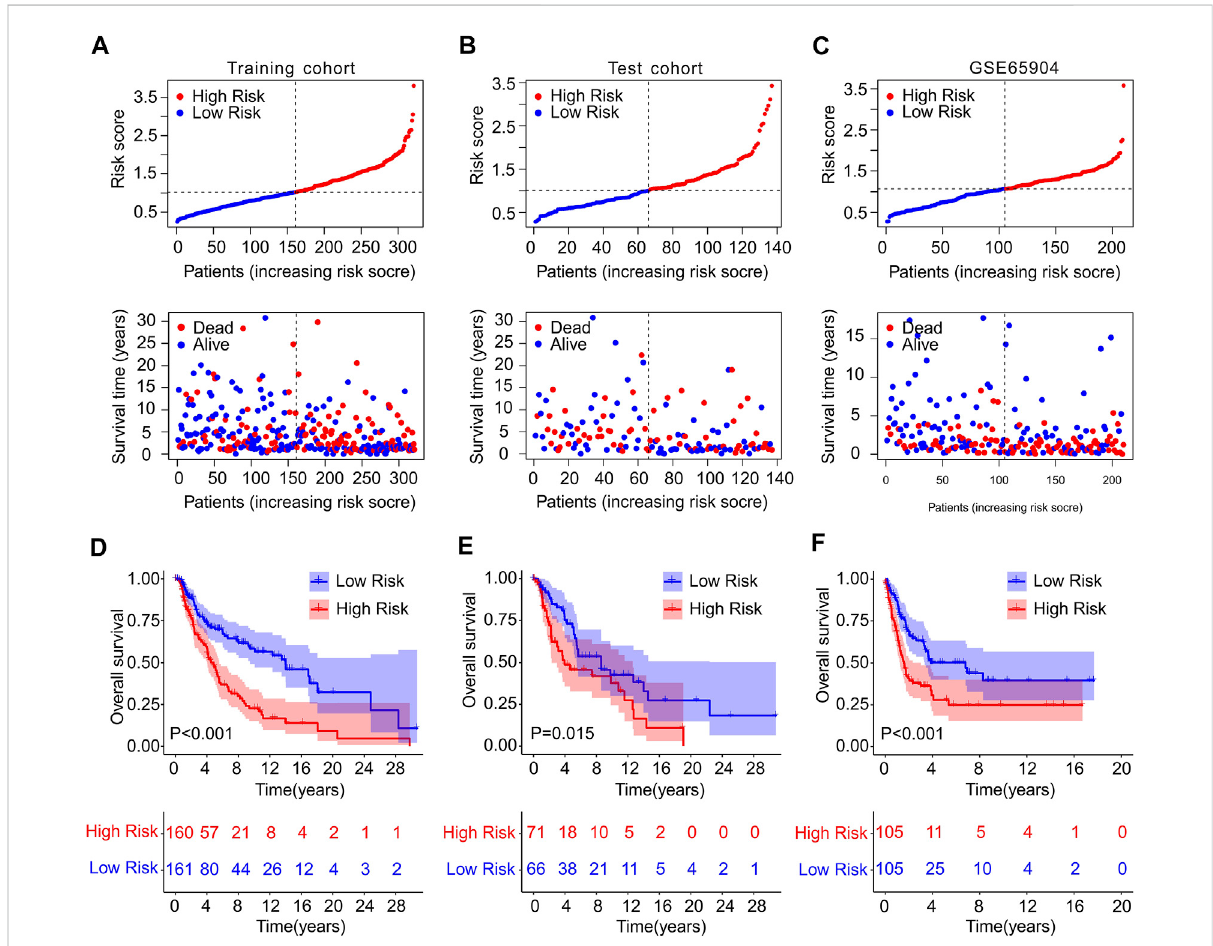
FIGURE 3 Risk model construction in training cohort and test cohort and GSE65904. The distribution of risk score calculated by ICD-related genes prognostic signature and the scatter dot plot shows the association of risk score and survival time in (A) Training cohort, (B) test cohort, (C) GSE65904. (D – F) The Kaplan-Meier survival curve displayed the OS rate of patients with CM in low- and high-risk group in training cohort, test cohort, and